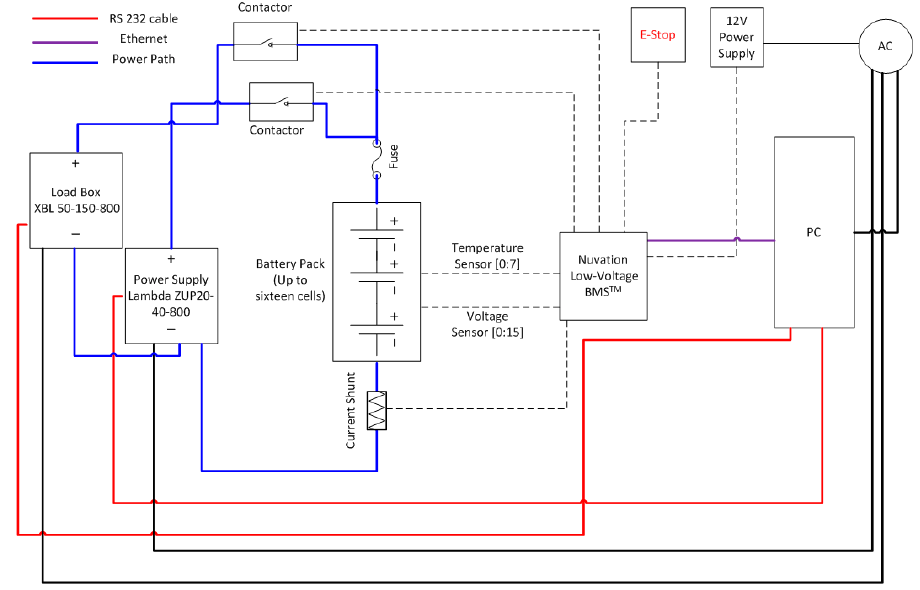
Figure 1. Test bench used in validating the resistance estimation algorithms.